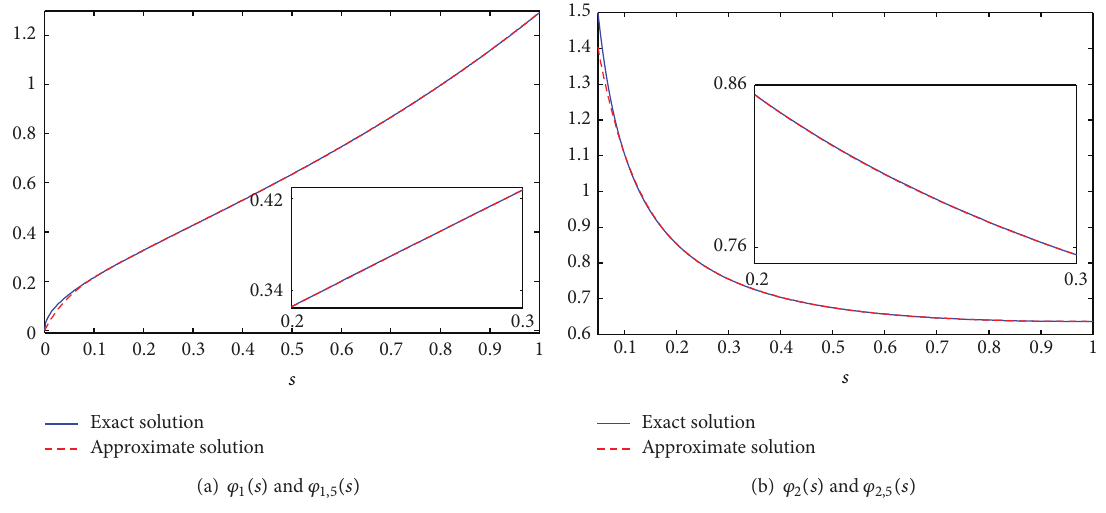
Figure 1: Comparison of the exact and approximated solutions for Example 2.